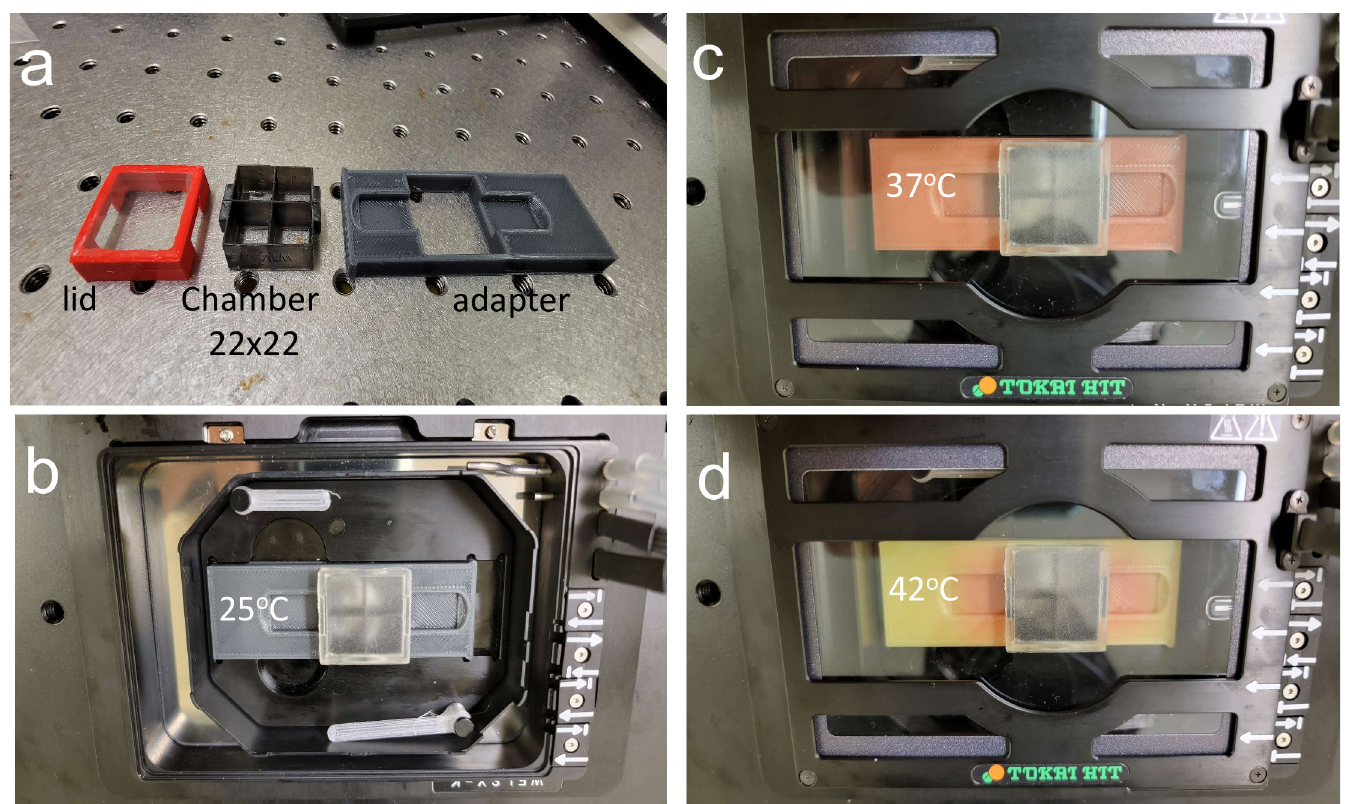
Fig 4. Sample live cell confocal microscopy data. RPE1 cell expressing PARP1 chromobody as red fluorescent protein fusion. (a) After 24 hrs growth, immediately after 405nm laser irradiation in the region defined by yellow box. (b) 12 seconds later. Panel c, 25 seconds later, showing PARP1 chromobody recruitment to the site of induced DNA damage. Scale bar is 10um. Timestamp is seconds and milliseconds. 60X oil objective.